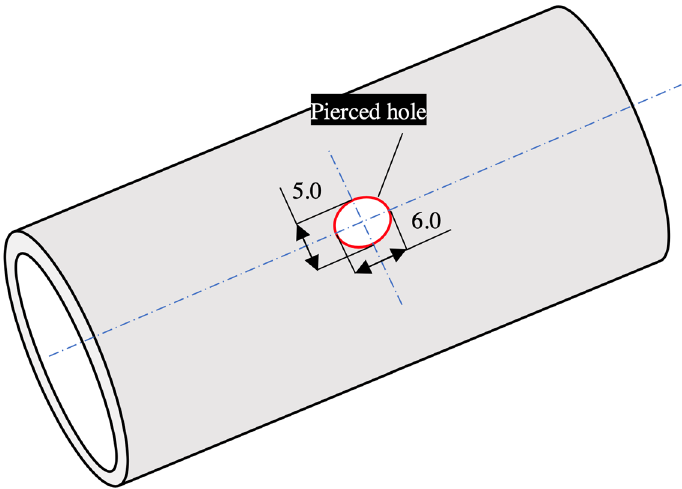
Figure 7. Schematic image of piercing hole shape on the steel tubes. Dimensions are in mm.